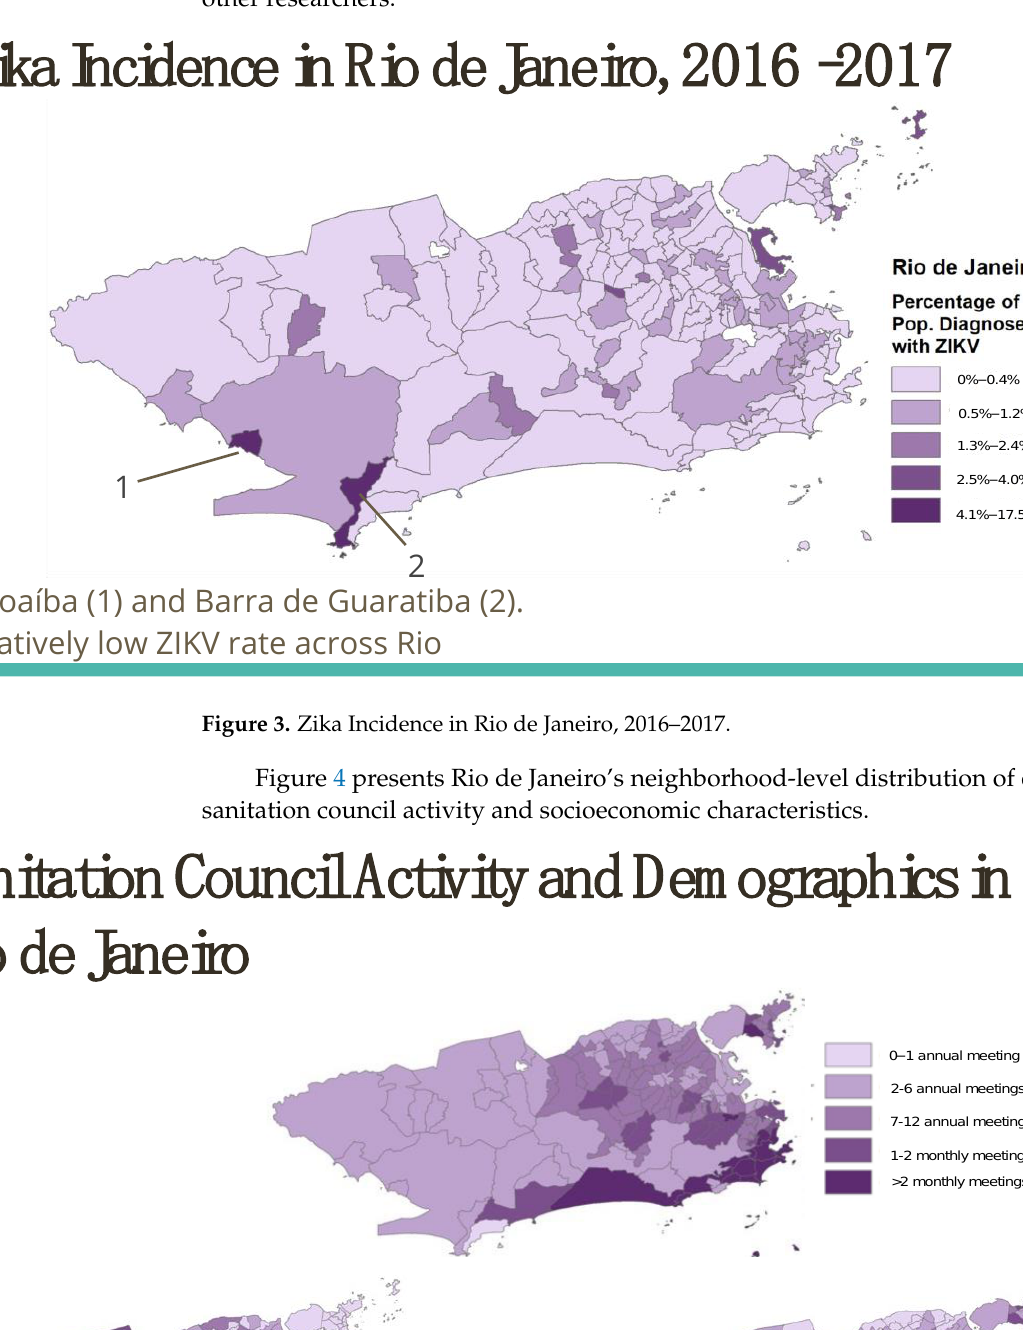
Figure 2. Zika Cases within Rio de Janeiro, 2016 – 2017.